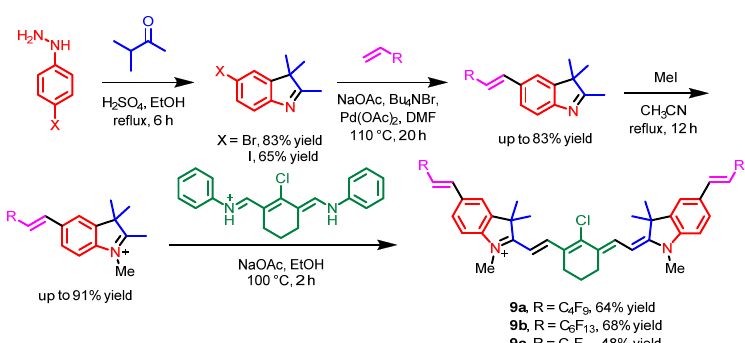
( b ) Figure 8. ( a ) ( A ) Epifluorescence, ( B ) confocal, and ( C ) differential interference contrast images of HeLa cells stained with (row 1) IR-786 iodide and (row 2) Dye 8 . ( b ) ( A ) Colocalization images of ( A ) Dye 8 and ( B ) MitoTracker Green (top)/MitoTracker Red (bottom) in mitochondria, and ( C ) dif- ferential interference contrast images. Adapted from [27].